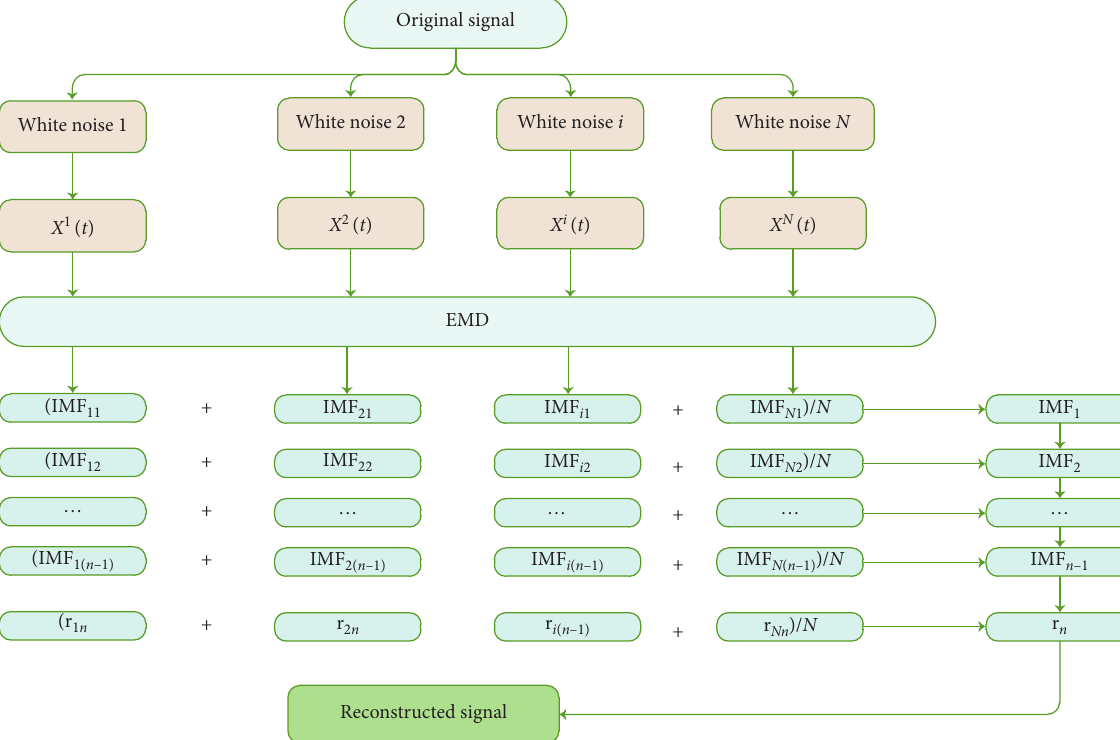
Figure 1: Flowchart of the EEMD